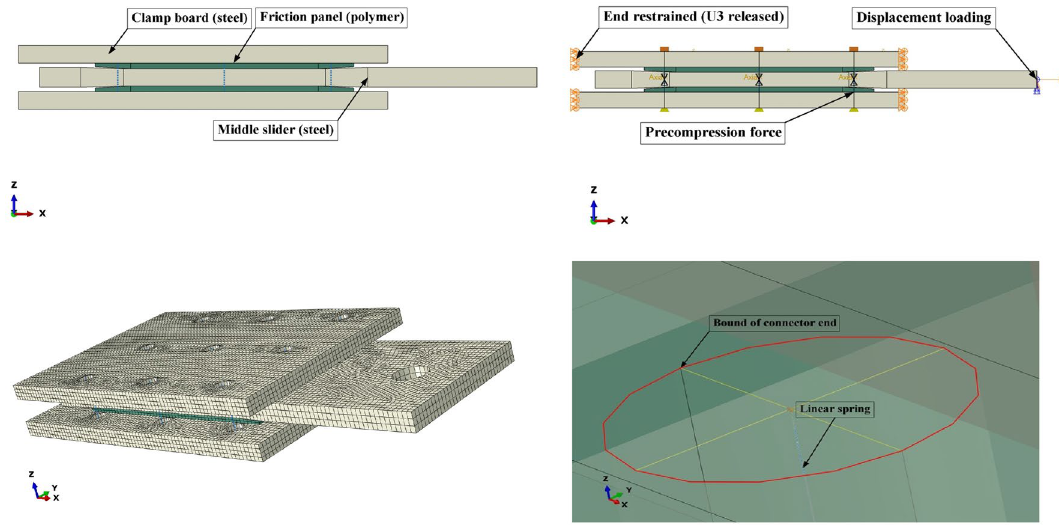
Fig. 17 Illustration of solid FEA model of tested